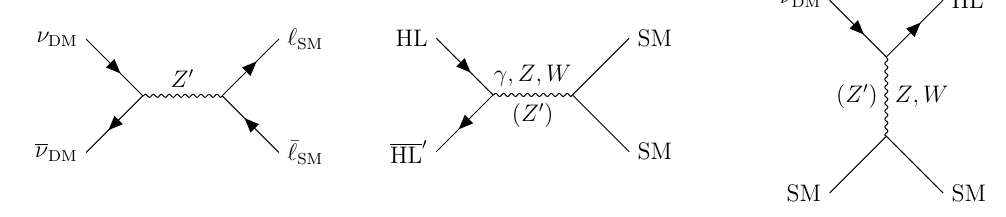
Figure 2 . Processes contributing to the depletion of the DM relic